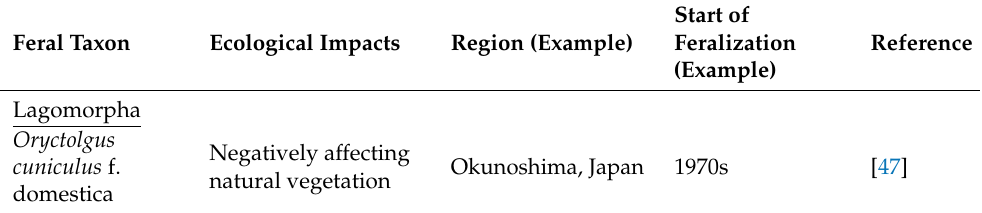
Table 1. Selected examples of feralization events of mammalian species and the ecological implica- tions. Temporal information relates to specific